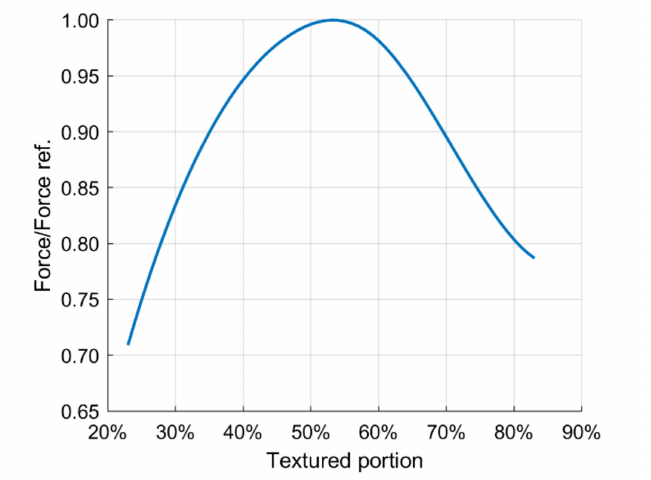
Figure 19. Force is generated by the partial texturing surface as a function of the textured portion. Square dimples with side 50 µ m and gap 10 µ m, sliding velocity 5 m /